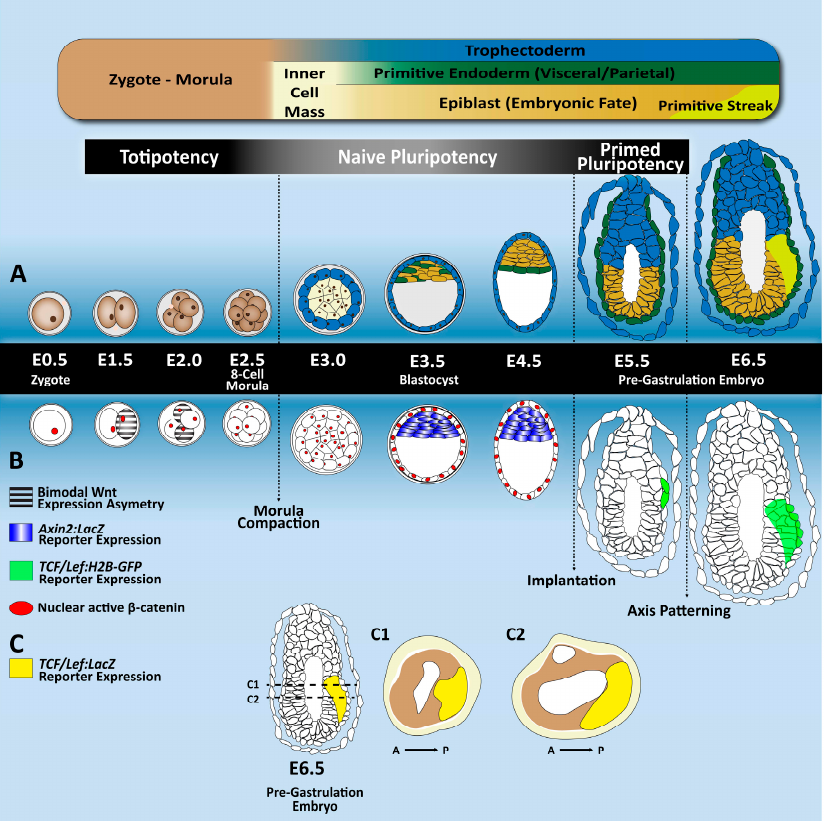
Figure 2. Tracing Wnt activity across early mouse embryogenesis. ( A ) A schematic overview of the mouse pre-implantation and post-implantation developmental stages, from zygote formation (E0.5) until the pre-gastrulation stage (E6.5). After fertilization, the zygote undergoes a series of mitotic divisions together with progressive cell fate acquisition. At the end of the morula stage, the first segregation event occurs giving rise to the trophectoderm and the inner cell mass (ICM). At E4.5–E5.0, after the ICM segregates into the epiblast and primitive endoderm, the blastocyst implants in the uterus. Around E6.5, the egg cylinder is formed, and anterior–posterior axis patterning is established, along with the first mesendodermal progenitors at the primitive streak. ( B ) This chart provides information about the main molecular changes in the Wnt/ β -catenin signaling pathway. The bimodal Wnt target gene expression is represented in grey stripes and is (at transcript level) already detected at the two- and four-cell stages [27]. In red, active nuclear β -catenin expression [28]. In blue, the Axin2 : LacZ reporter is found only at the blastocyst stage [29]. In green, detection of the TCF/Lef:Histone 2B-green fluorescent protein (H2B-GFP) reporter occurs only after implantation stages [30]. ( C ) Longitudinal and transversal sections of a pre-gastrulating mouse embryo (E6.5) showing in yellow the distribution of the TCF/Lef: β -galactosidase reporter activity in the posterior region [30].